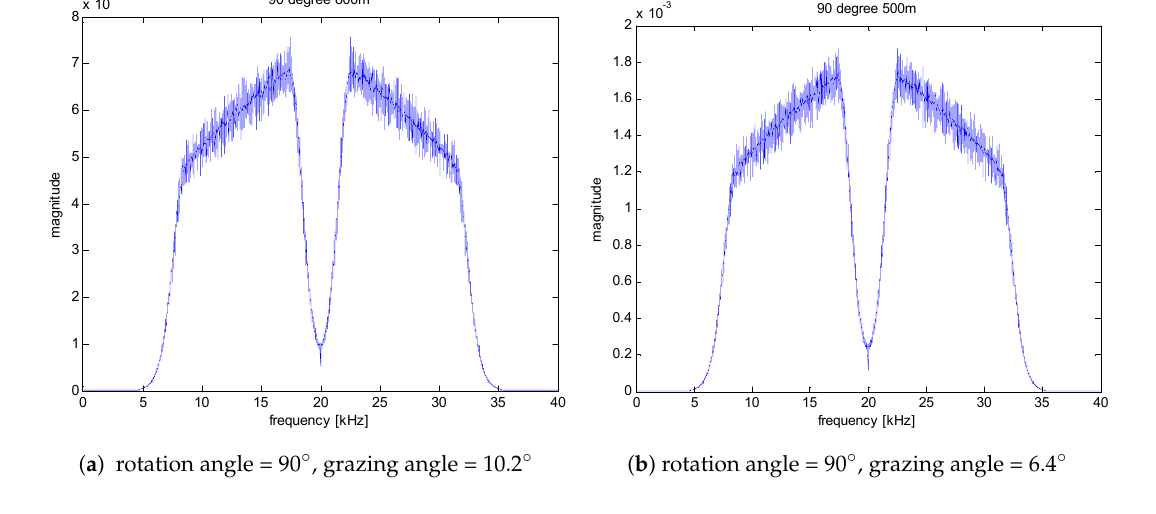
( a ) rotation angle = 90 ◦ , grazing angle = 10.2 ◦ ( b ) rotation angle = 90 ◦ , grazing angle = 6.4 ◦